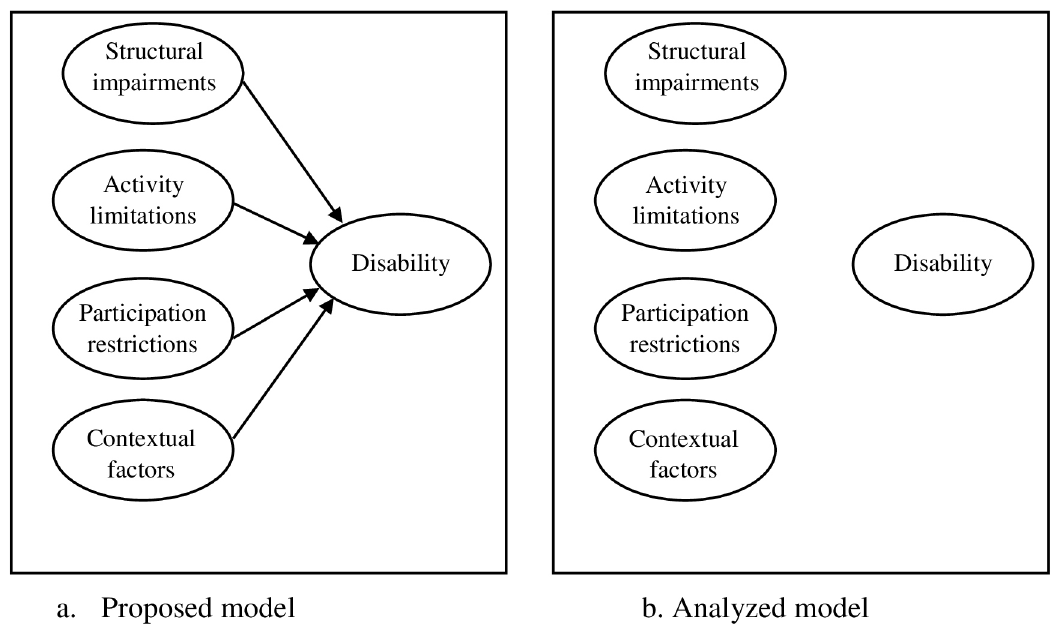
Fig 4. Confirmatory factor analysis of the second order measurement model. In the hypothesis model it was proposed for convergence of structural impairments, activity limitations, participation restrictions, and contextual factors toward disability (a). The analysis showed failed model